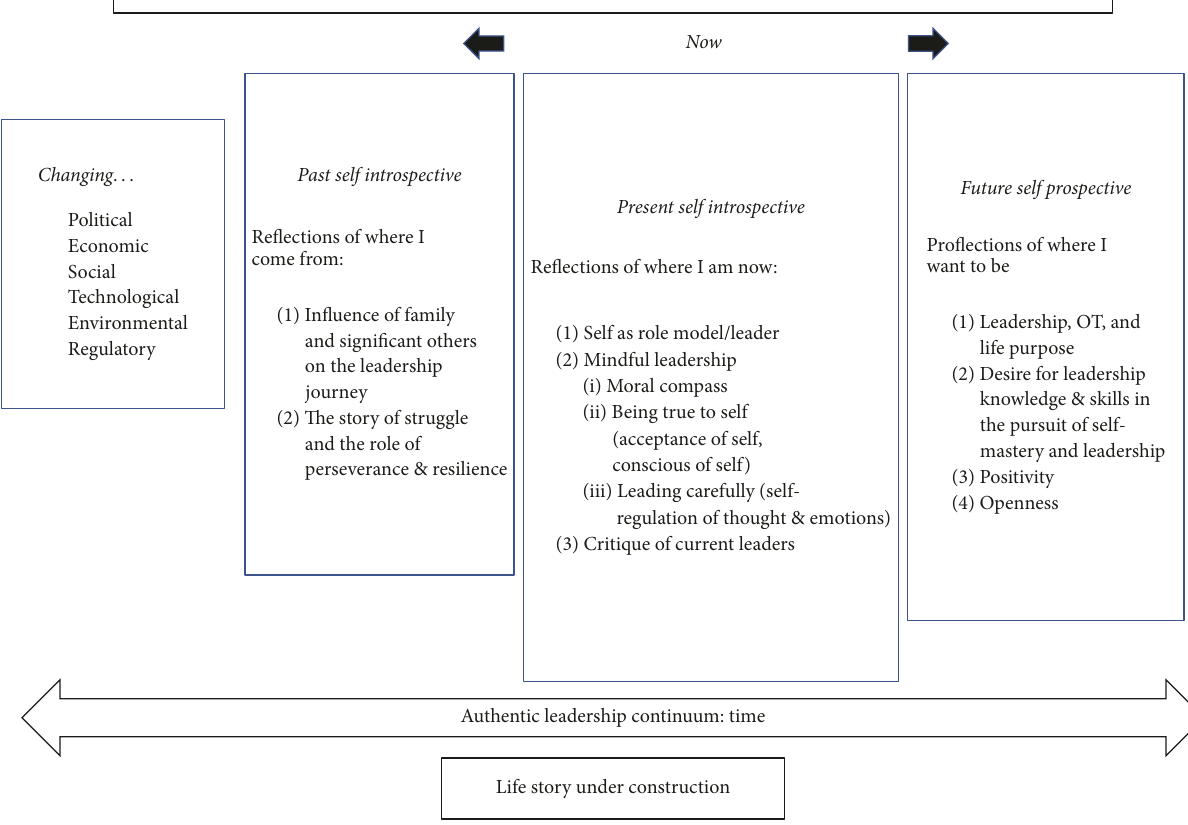
Figure 2: Working model of authentic leadership development for South African